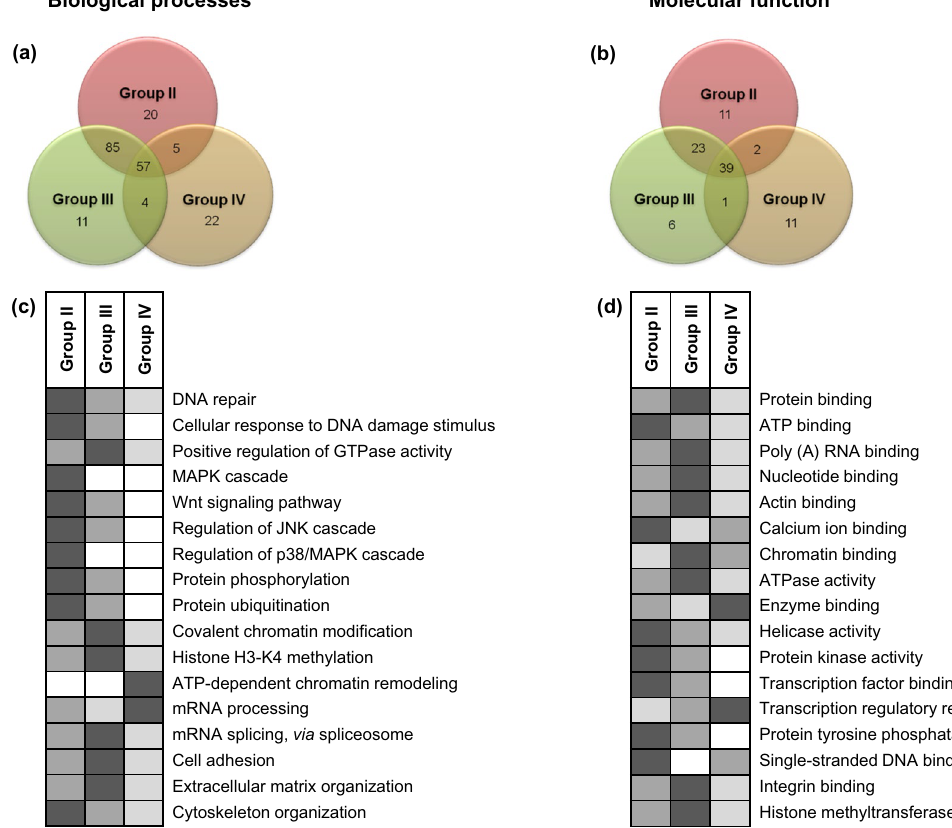
Figure 2. Functional classes of proteins altered with chronic low dose radiation in the three HLNRA dose groups relative to NLNRA dose group. Venn diagram of unique and overlapping. ( a ) Biological processes (GO analysis) and ( b ) Molecular function (GO analysis). Comparative analysis of representative enriched categories for the three HLNRA dose groups. ( c ) Biological processes GO terms and ( d ) Molecular function GO terms. The intensity of shading indicates significance (Fisher’s exact test P-value) of enriched GO categories with the darkest grey intensity showing the lowest P-value. All gray boxes have a Fisher’s exact test P-value of ≤ 0.05; white boxes indicate enriched GO categories with non-significant P-values (≥